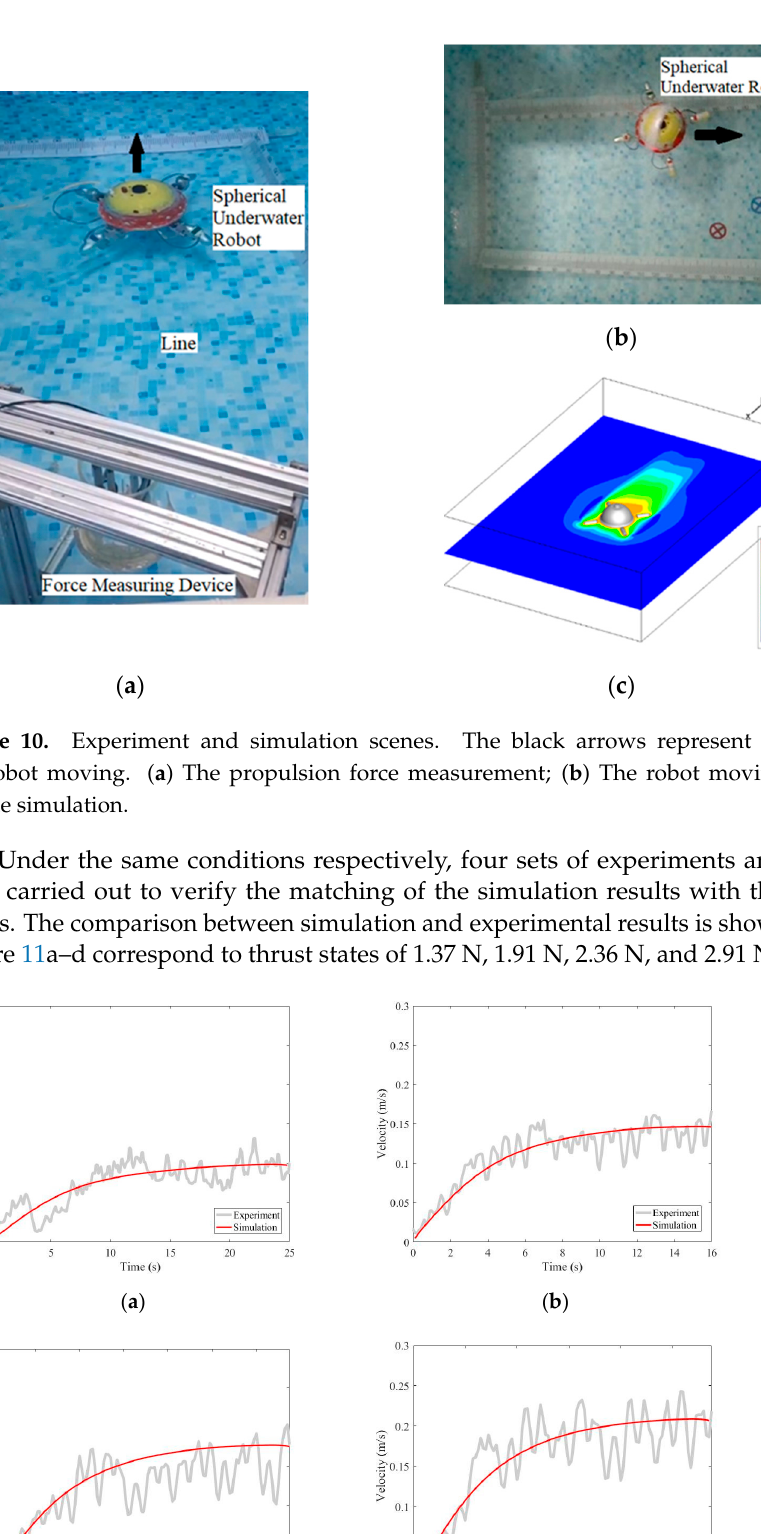
12 of 21 Table 1. Comparison of related parameters in flow around cylinder. Re